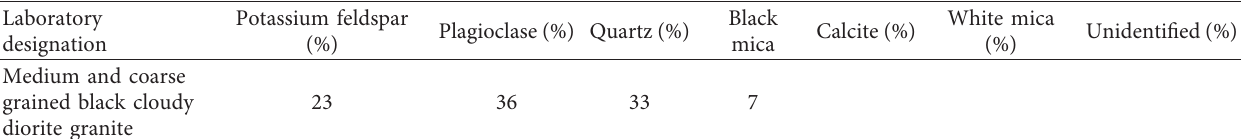
Table 2: Composition of rock samples.